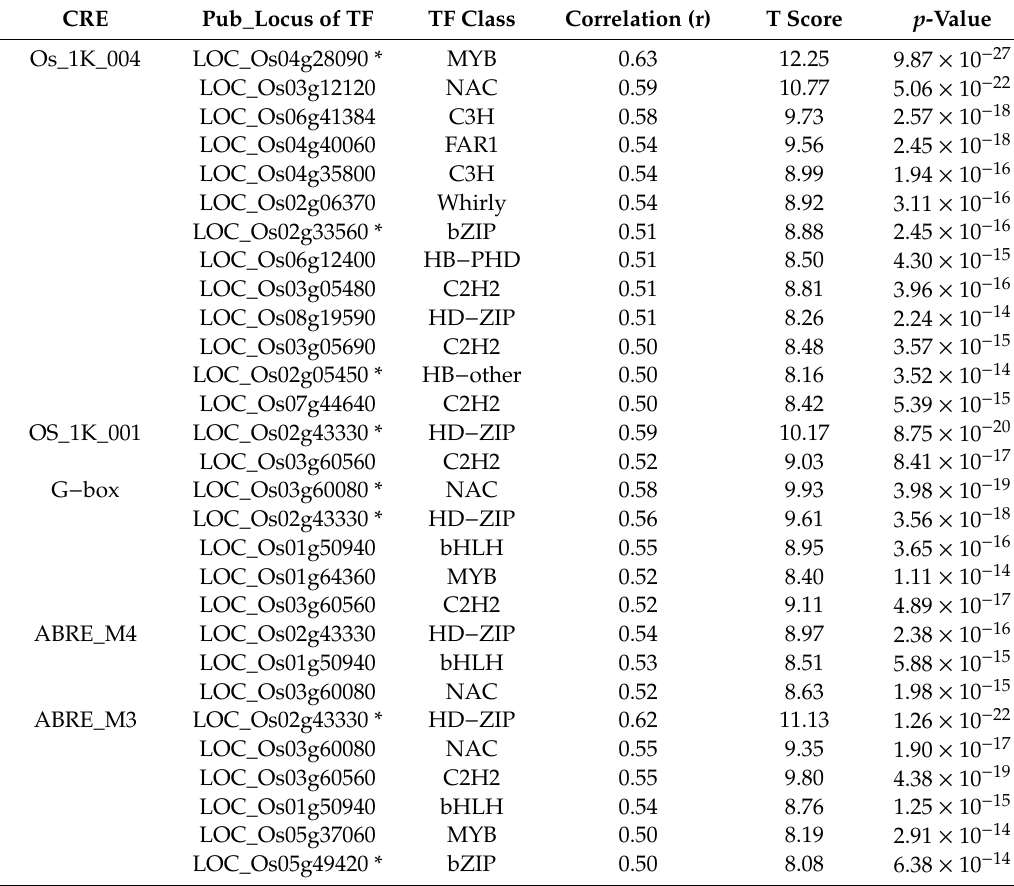
Table 5. Transcription factors (TFs) that are significantly ( p < 0.05) and highly associated to predicted